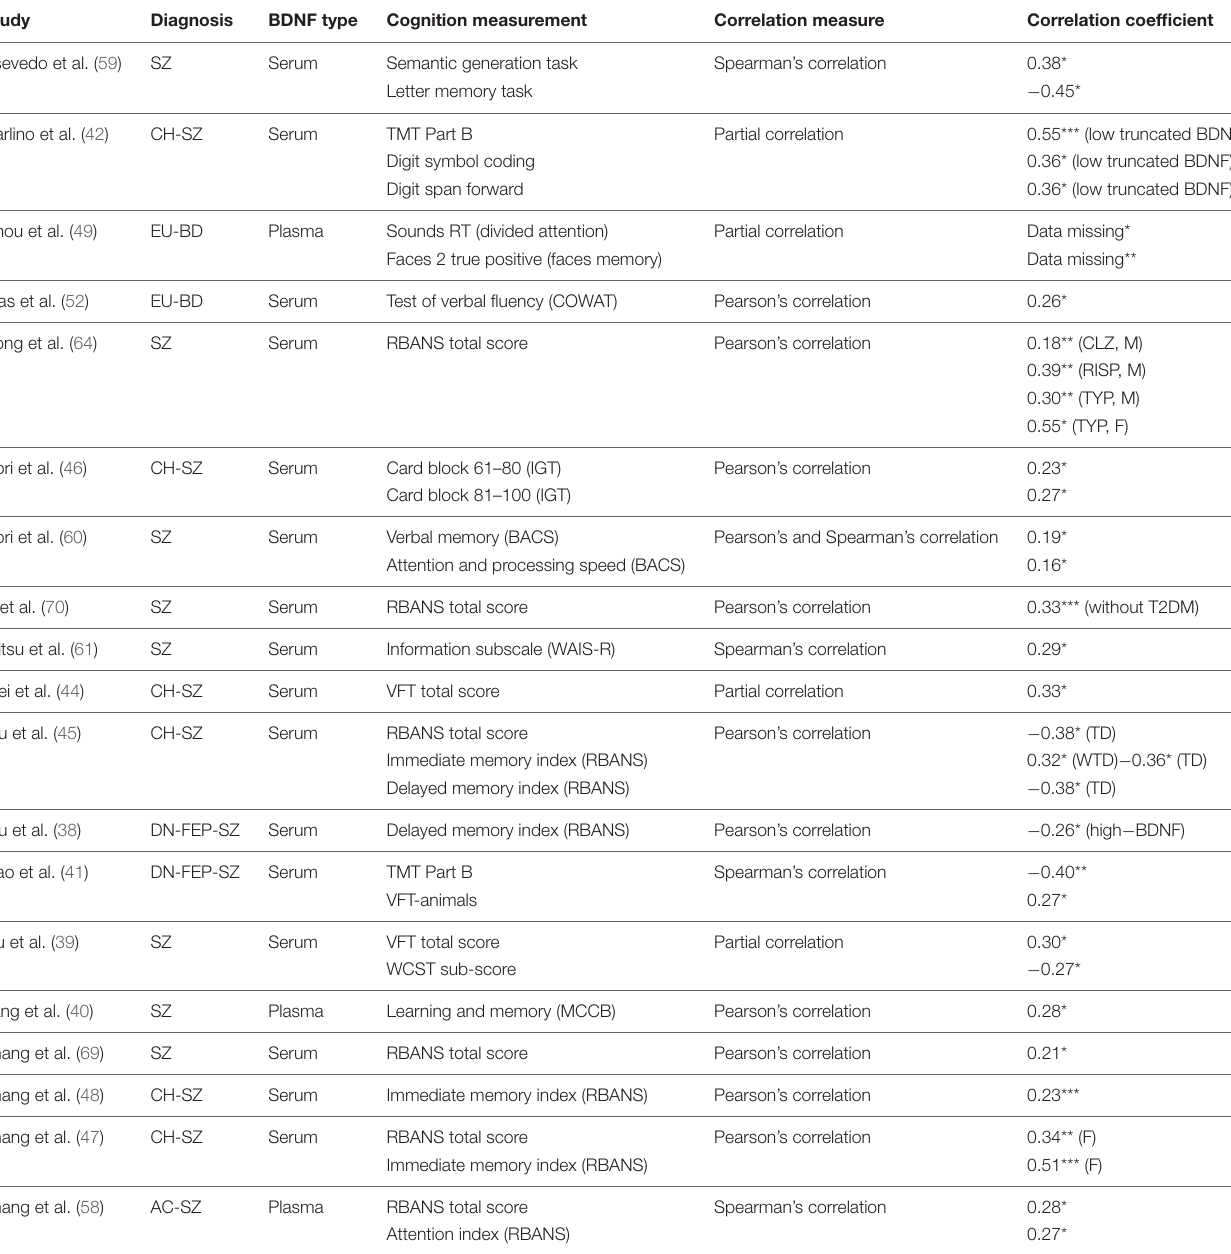
TABLE 3 | Correlations between BDNF levels and